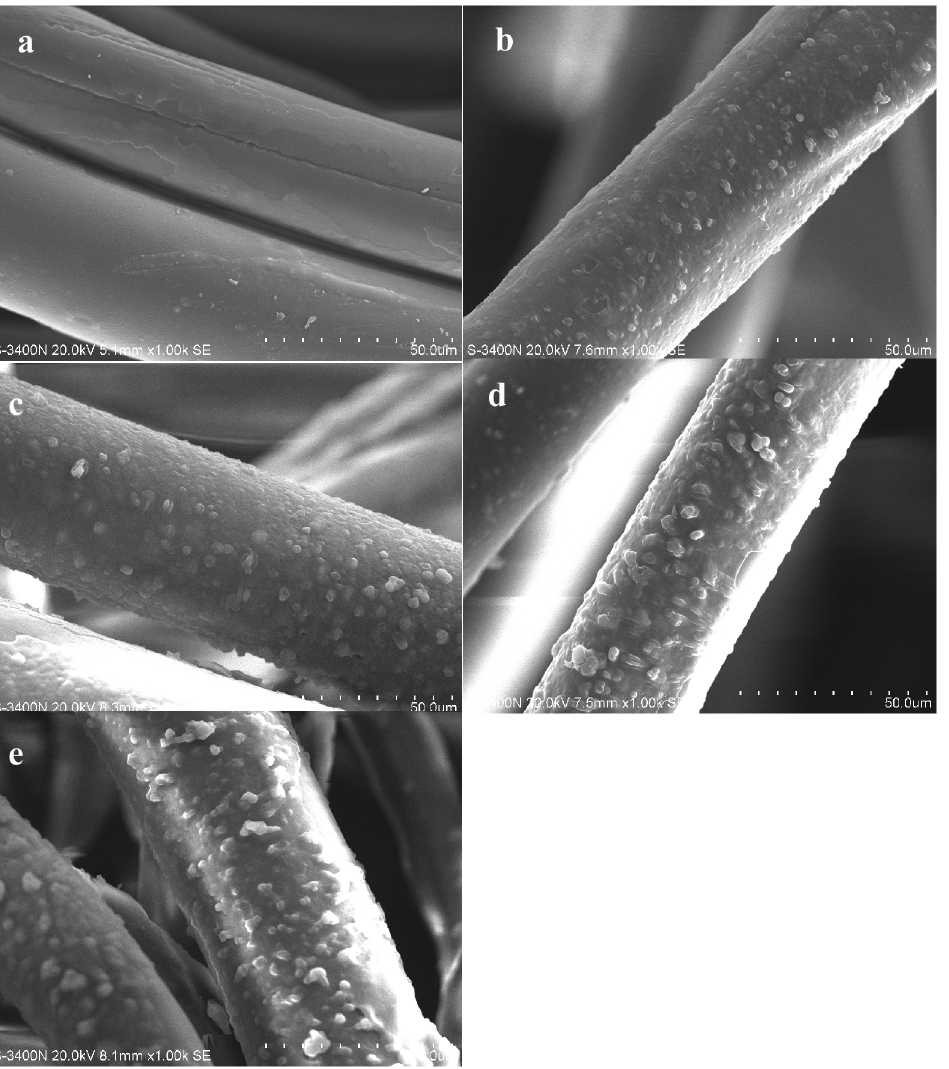
Fig 9. The SEM images of the SACEF adsorbing reserpine at different contact time. (a) SACEF before adsorption; (b) SACEF adsorbing reserpine after 1 min;(c) SACEF adsorbing reserpine after 5 mins;(d) SACEF adsorbing reserpine after 10 mins;(e) SACEF adsorbing reserpine after 90